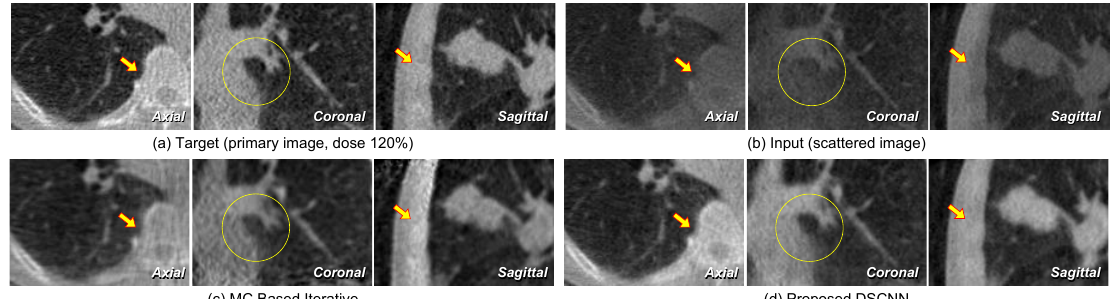
Figure 13. Magnified images of the yellow rectangle regions in Figure